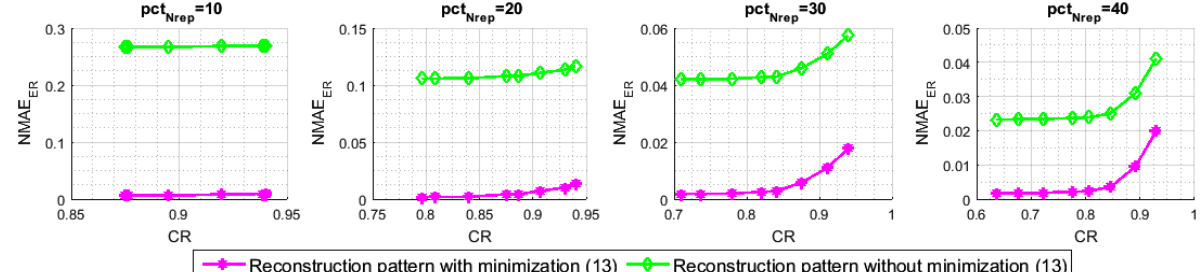
Figure 16. The impact of spatial interpolation technique on the NMAE ER